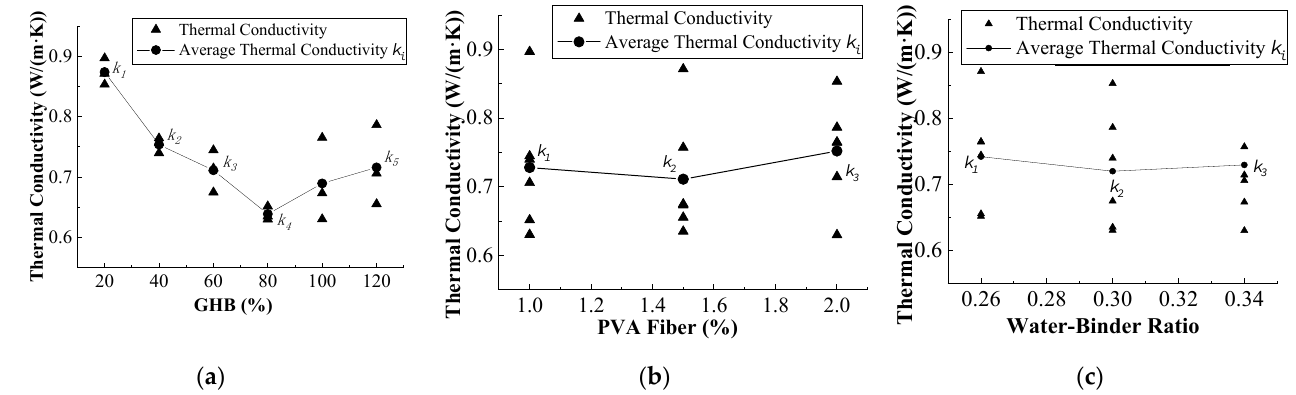
Figure 6. Relationship of GPCC thermal conductivity with each factor: ( a ) GHB content; ( b ) PVA fiber content; ( c ) water-binder ratio.